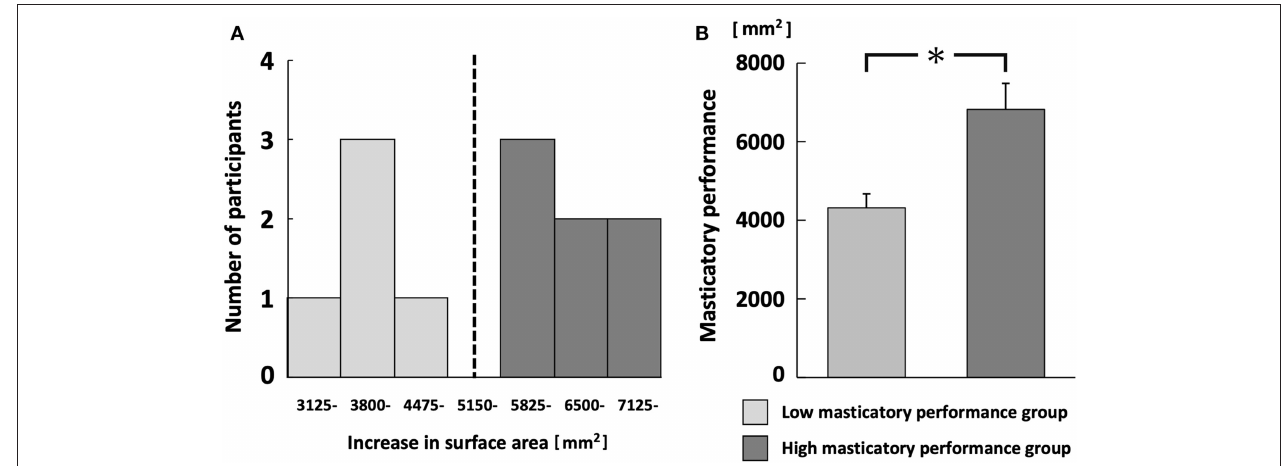
FIGURE 2 | Histogram of masticatory performance (A) and comparison between low and high masticatory performance groups (B) . Black dotted line in (A) separates low and high masticatory performance groups. * p < 0.05.